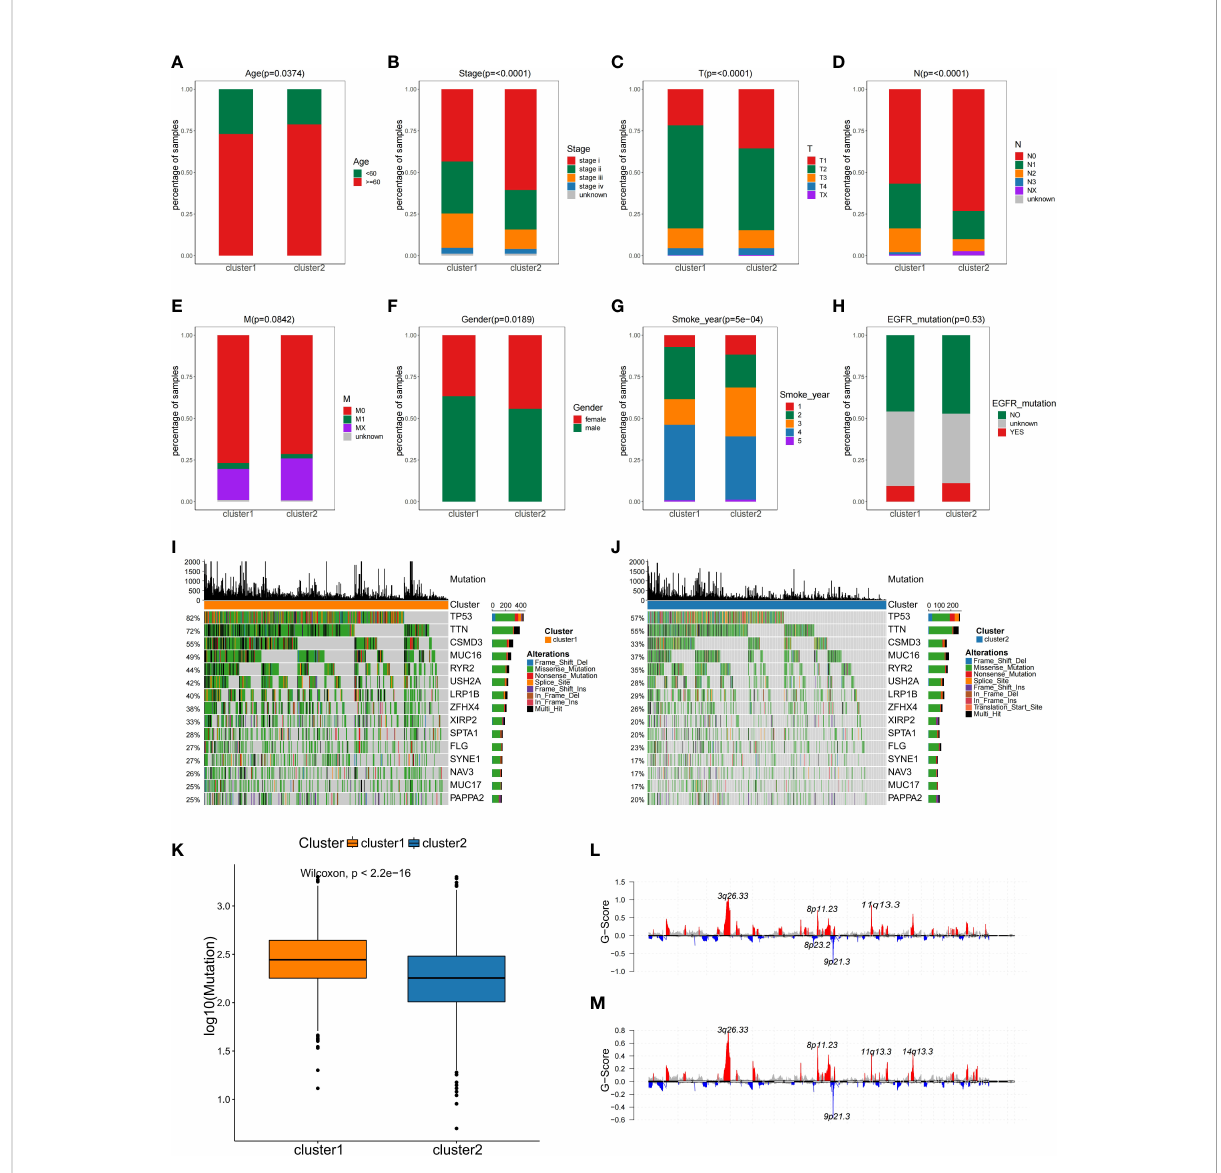
FIGURE 3 The comparisons of the clinical features between two NSCLC subtypes. (A – H) Analysis of clinical features between NSCLC subclasses by Fisher ’ s exact test. (I, J) Comparison of mutation alterations among subtypes in the training set. OncoPrint of mutation status of 15 shared genes among the top 20 in C1 (I) and C2 (J) . (K) Comparison of the absolute mutated number between NSCLC subclasses. Distribution of somatic copy number alteration in C1 (L) and C2 (M)